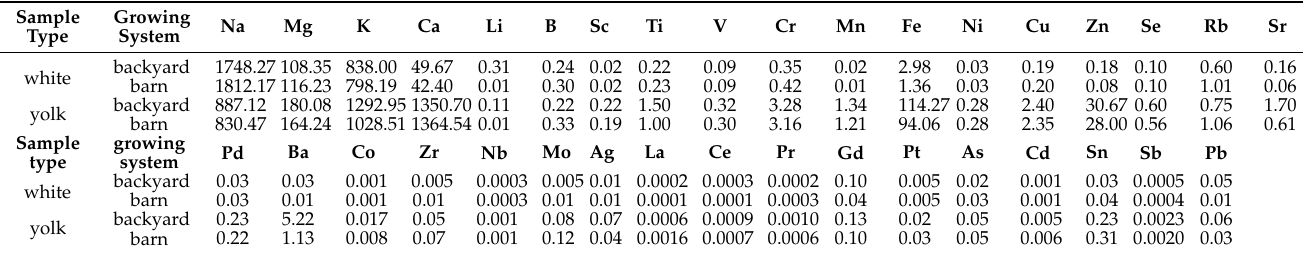
Table 2. The mean concentration (in mg/kg fresh weigh) of all investigated elements by